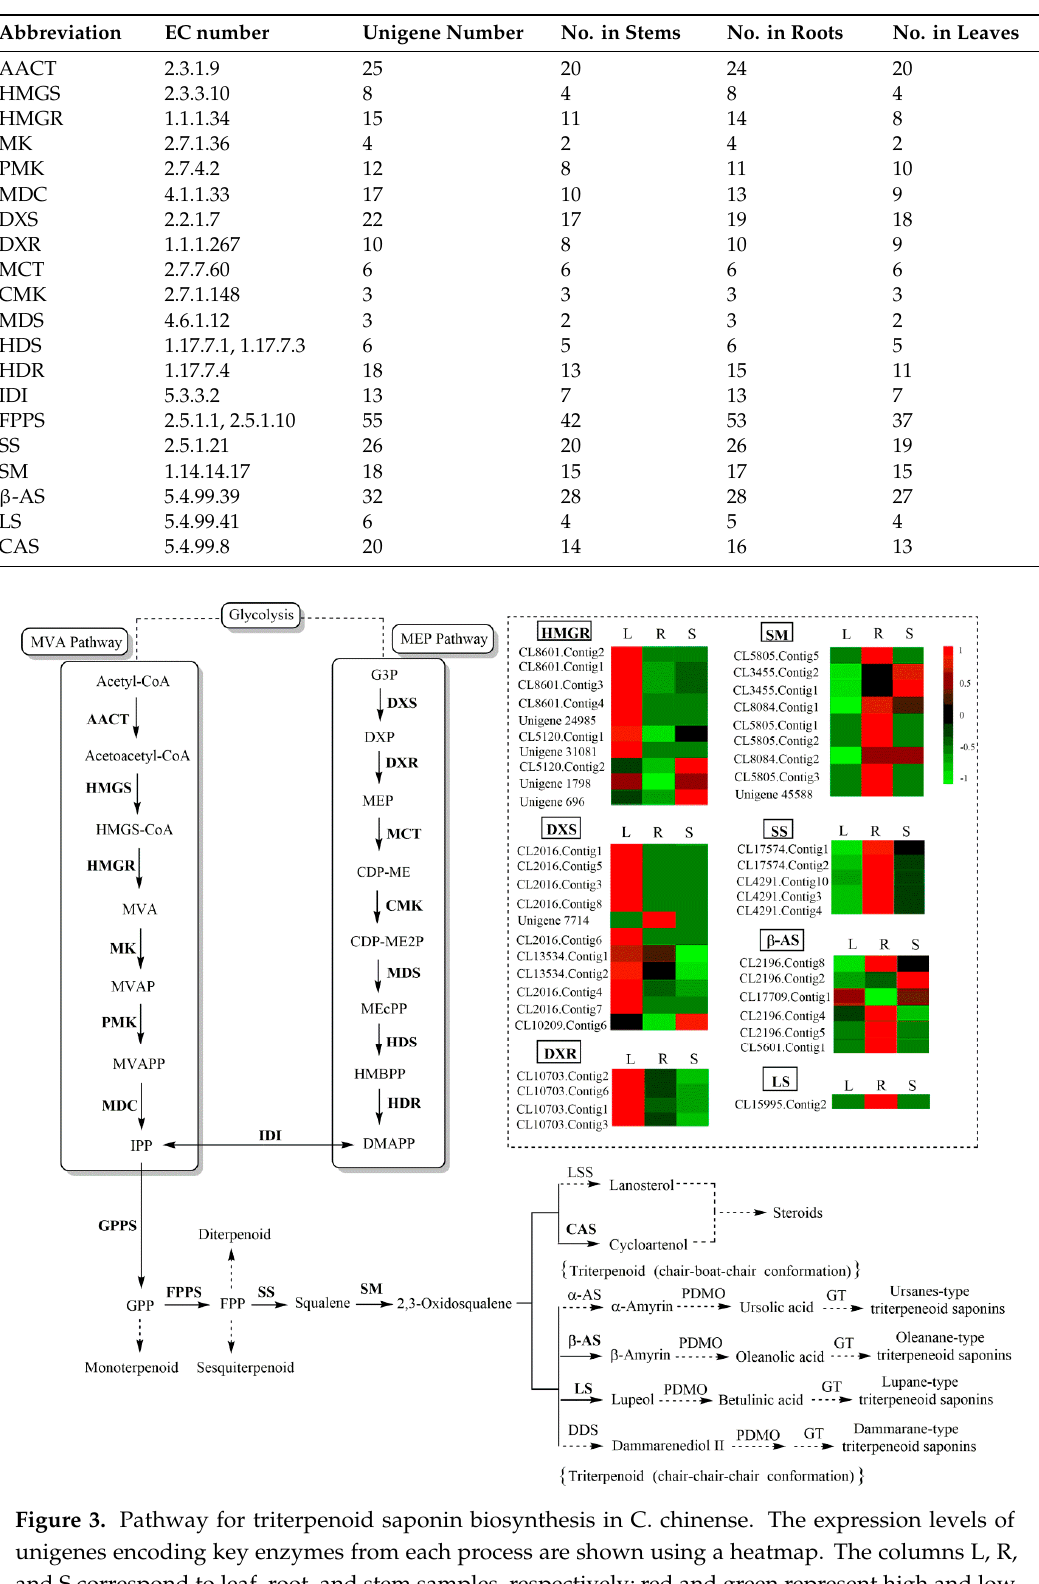
Table 2. Number of unigenes encoding the key enzymes involved in the biosynthesis of triterpenoid saponins in C. chinense.